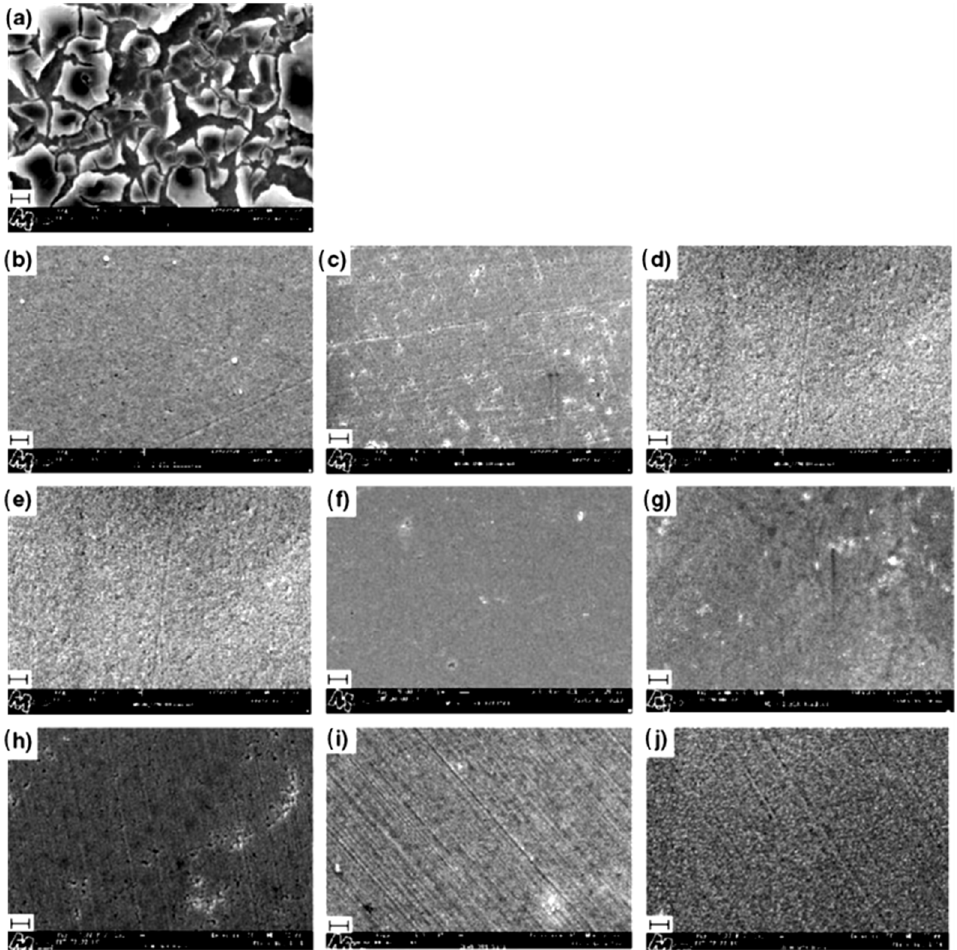
Figure 9. SEM micrographs of Ni coating of 2.0 C cm − 2 obtained chronoamperometrically from − 0.20 to − 1.40 V. Electrolytic solution: ( a ) Wath (W1); ( b ) W1 + 0.26 M glycerol, ( c ) W1 + 0.39 M glycerol, ( d ) W2 + 0.52 M glycerol, ( e ) W1 + 0.26 M mannitol, ( f ) W1 + 0.39 M mannitol, ( g ) W2 + 0.52 M mannitol; ( h ) W1 + 0.26 M sorbitol, ( i ) W1 + 0.39 M sorbitol, and ( j ) W2 + 0.52 M sorbitol. Reprinted with permission from Table 1. A summary of previous studies showing the effects of additives on electrodeposited Ni coatings.